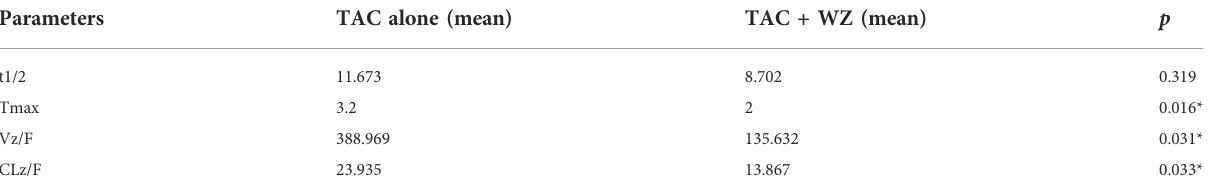
TABLE 2 The paired t-test result of pharmacokinetic parameters in liver transplant patients ( n =